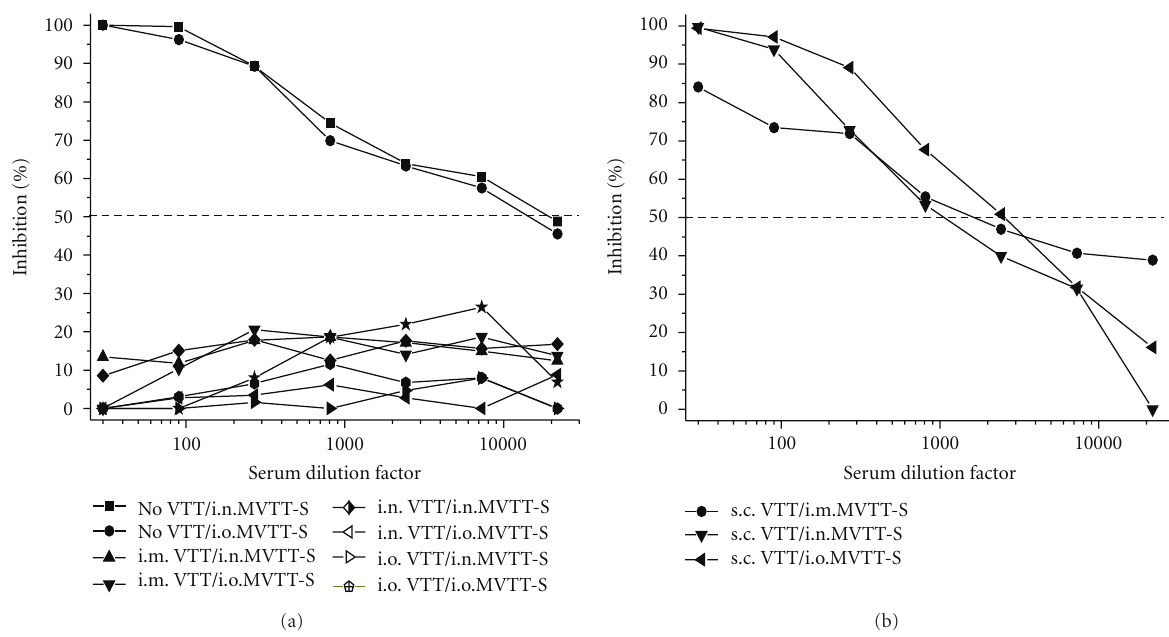
Figure 2: Anti-S neutralizing antibody responses in VTT-vaccinated mice after two MVTT-S challenges. (a) Serum samples of i.m., i.n., and i.o. VTT-vaccinated as well as of placebo-inoculated (no VTT) mice were tested. (b) Serum samples of s.c. VTT-vaccinated mice were tested. Pooled sera, which contain an equal amount of serum of each vaccinated mouse in each group, were subjected to each experiment. The X -axis represents the serum dilution factor whereas the Y -axis indicated the percentage of viral inhibition. The dashed horizontal line indicates IC 50 values. The experiment was repeated twice with similar results obtained.